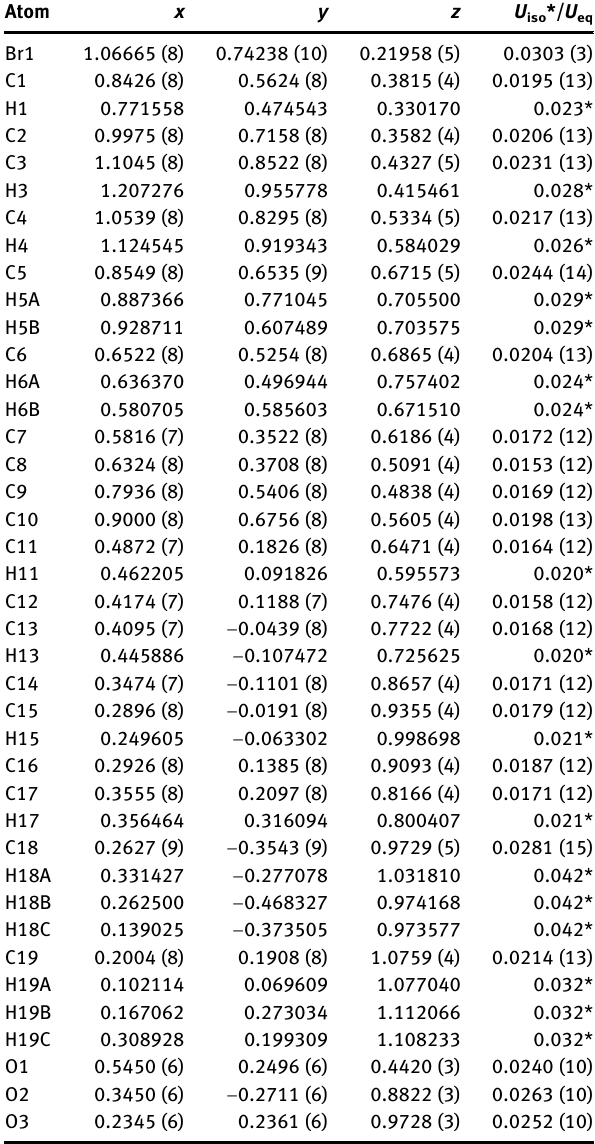
Table  : Fractional atomic coordinates and isotropic or equivalent isotropic displacement parameters (Å 